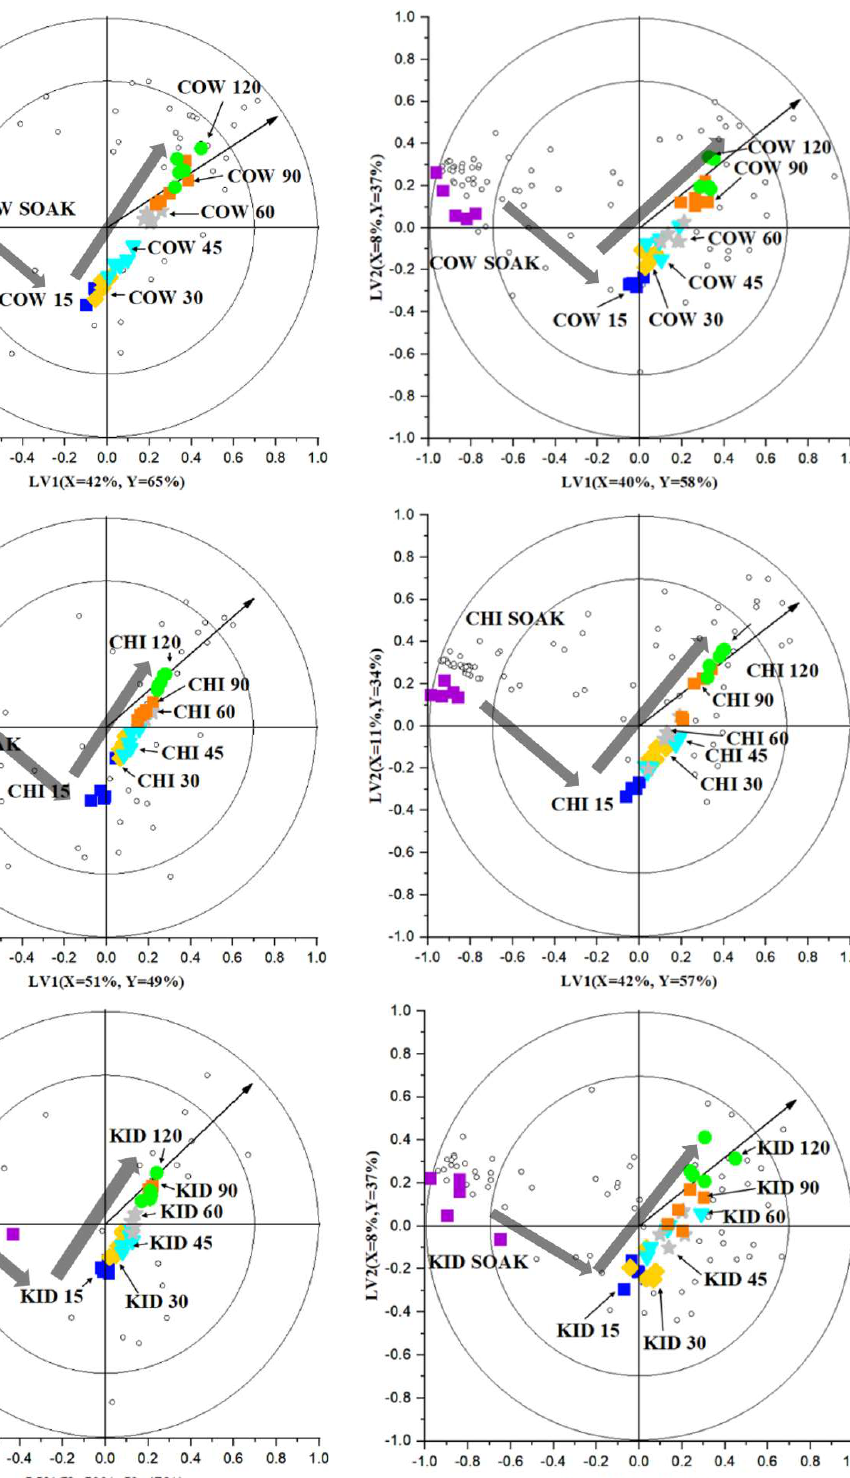
Figure 2. A bi-plot based on partial least square regression (PLS-R) comparing the volatile profiles among treatments of three types of legumes as a function of the hydrothermal processing time (0 (labelled SOAK on the figure), 15, 30, 45, 60, 90, 120 min). The thick transparent grey arrows are added to indicate the change from soaked to processed samples. The percentages of X- and Y-variances explained by each latent variable (LV) are specified on each respective axis. From all bi-plots, there is a clear separation in the soaked ( t c = 0 min) compared to the processed ( t c ≥ 15 min) samples represented in a V-shaped trend pivoting to the processed sample group ( t c ≥ 15 min; Figure 2). This non-linear pattern suggests that multiple com- plex reactions could concurrently occur as a function of the processing time. As processing begins, the classes on the bi-plot pivot from the far left-middle of the bi-plot to just under- neath the centre of the coordinate ( t c = 15 min), indicating an apparent effect of processing, even with just 15 min of boiling. After that, as processing time increased towards 120 min, the samples projected further away from the origin into the upper right quadrant, increas- ing (positive) loading for both LV1 and LV2. Interestingly, this trend was consistent for all three legumes across both open and closed systems. The distribution of the volatile compounds on the plot can be examined closer to monitor their change as a function of processing times. Volatile compounds positioned further away from the centre of the coordinate have a higher loading for the effect of time; therefore, processing plays a vital role in the observed classification. Indeed, many of them are projected away from the origin and positioned near the soaked samples, as well as a few towards the highest processing time ( t c = 120). The close proximity of these com- pounds to a sample shows that they are found in greater quantities in those respective samples. The two rings on the bi-plots show the confidence level of each volatile, contributing to the selection of LVs and classification/volatile changes. Specifically, those volatiles po- sitioned between the inner and outer rings are within 70% to 100% confidence and are the compounds that change the most during processing. The closed system bi-plots (Figure 2) show more compounds within the two rings closer to the soaked sample, indicating the loss of an increased number of volatile compounds due to processing. This is the primary trend when visually investigating the bi-plots. Conversely, few volatile compound are projected in the direction of the processed samples, illustrating that a small number have increased or are formed due to hydrothermal processing. Overall, the bi-plot presents vis- ual evidence of a clear pattern/trend due to hydrothermal processing. Next, the VID coef- ficients were calculated to rank the volatile compounds based on their importance for the classification. A high positive VID coefficient indicates an increase in the abundance of volatile compounds as a function of t c , whereas a negative coefficient indicates a decrease.